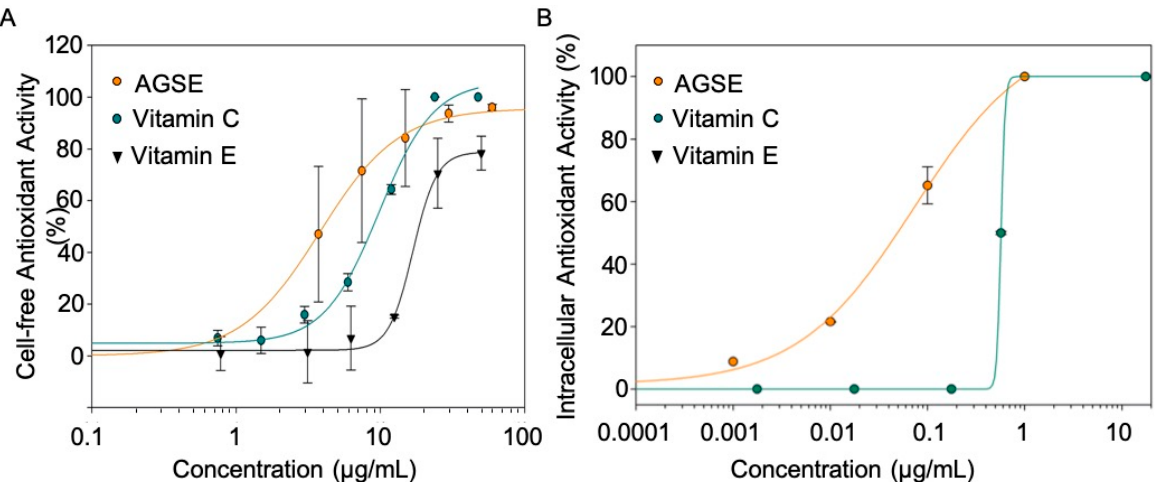
Figure 3. AGSE possesses potent antioxidant activity. ( A ) Cell-free antioxidant capacity of actives were measured via the ABTS assay by metmyoglobin. ( B ) Intracellular antioxidant activity was measured in NHDFs after incubation for 3 h. The activity was determined using DCFH-DA marker of oxidative stress after H 2 O 2 -induction. The IC 50 is the concentration of compound producing half maximal inhibition. Data represents mean ± SD from three independent experiments.